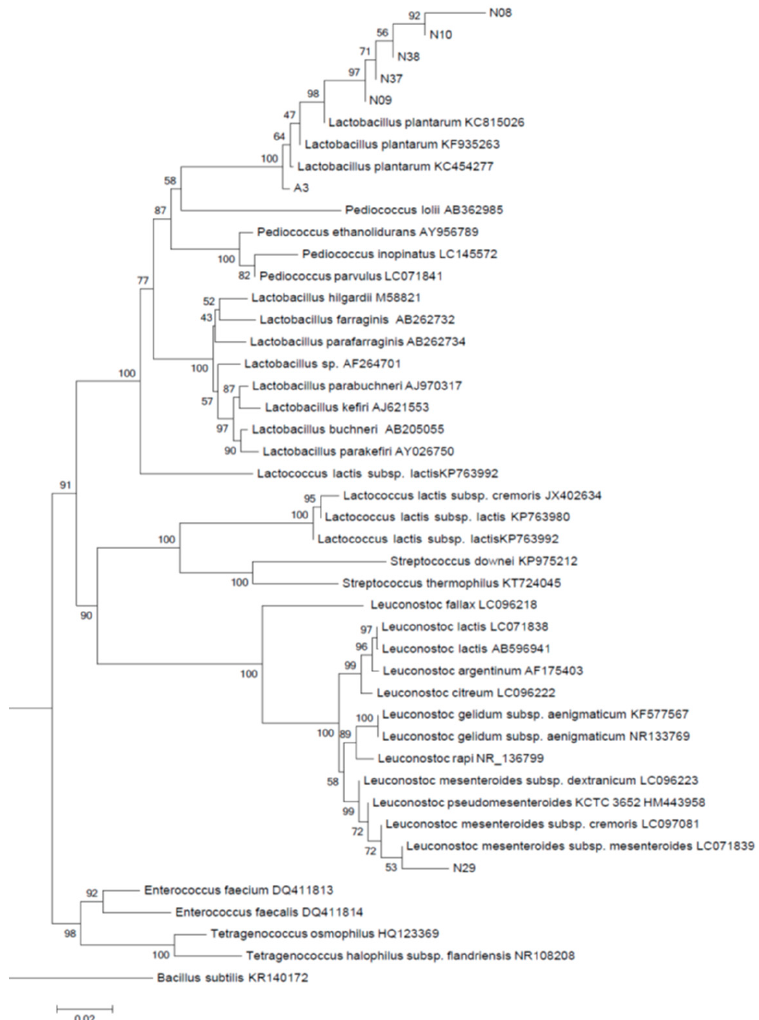
Figure 2. Phylogenetic tree by the neighbor-joining method based on the sequence of 16S rRNA gene of LAB isolated in this study and corresponding region of LAB obtained from NCBI database. The bootstrap value was 1000 replicates. The scale at the bottom indicates the evolutionary distance of nucleotide substitution per site.